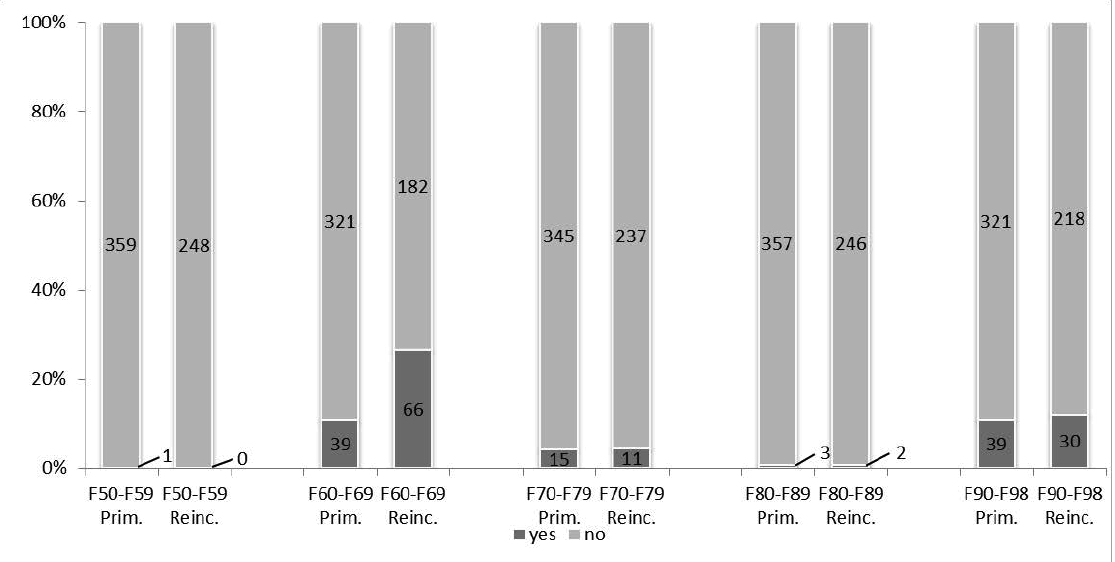
Figure 2 . Psychiatric associations to primary offenders and recidivism for F50-F98